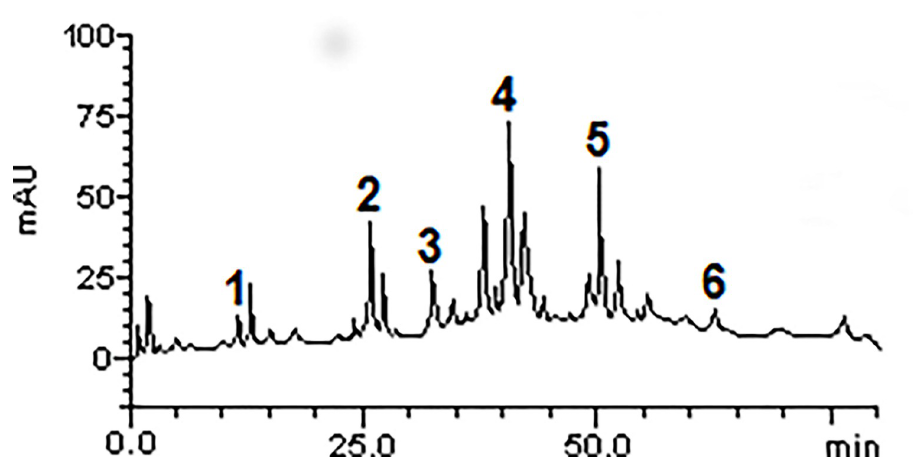
Fig 1. HPLC-DAD chromatogram of AEAMP. Cyanidin (peak 1), Vanillin (peak 2), Benzoic acid (peak 3), Luteolin (peak 4), Resorcinol (peak 5) and Quercetin (peak 6). AEAMP: aqueous extract of Annona muricata peel.